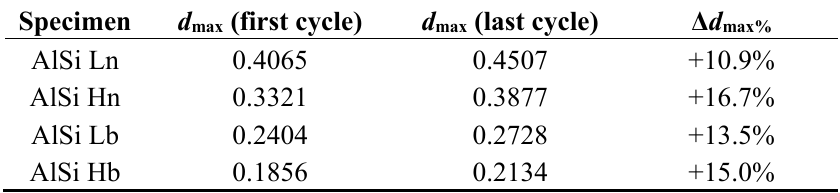
Table 2. Summing up the evolution of displacement of each specimen tested. Values are in